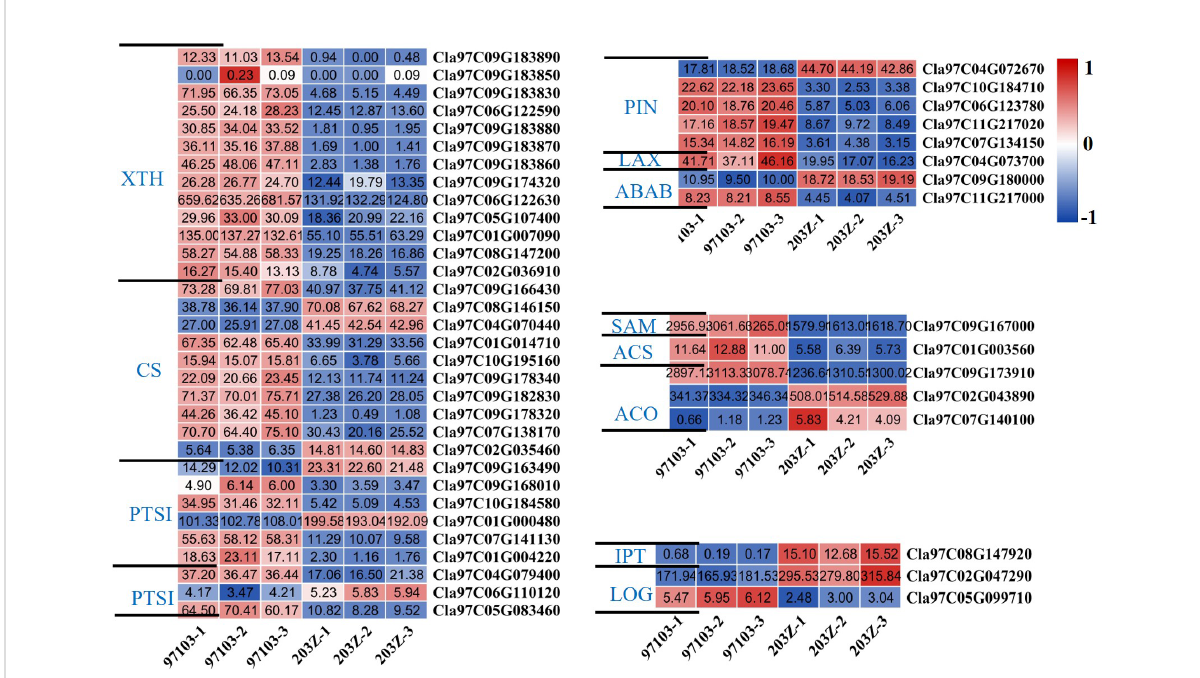
FIGURE 5 Heat map of differentially expressed genes related to seed expansion or hormone synthesis (auxin, ethylene, cytokinin). The darker the red color in the color scale, the higher the relative expression of the gene in the sample; the darker the blue color, the lower the expression of the gene in the sample. The value in the box represents the FPKM value in the sample. XTH, Xyloglucan endotransglucosylase/hydrolase; CS, Cellulose synthase; PTS, Pectinesterase; PTSI, Pectinesterase inhibitor; PIN, Auxin ef fl ux carrier component; LAX, Auxin transporter-like protein; ABAB, ABC transporter B family member; SAM, S-adenosylmethionine; ACS, 1-aminocyclopropane-1-carboxylate synthase family protein; ACO, 1-aminocyclopropane-1-carboxylate oxidase 1; LOG, Cytokinin riboside 5 ’ -monophosphate phosphoribohydrolase; IPT, Adenylate